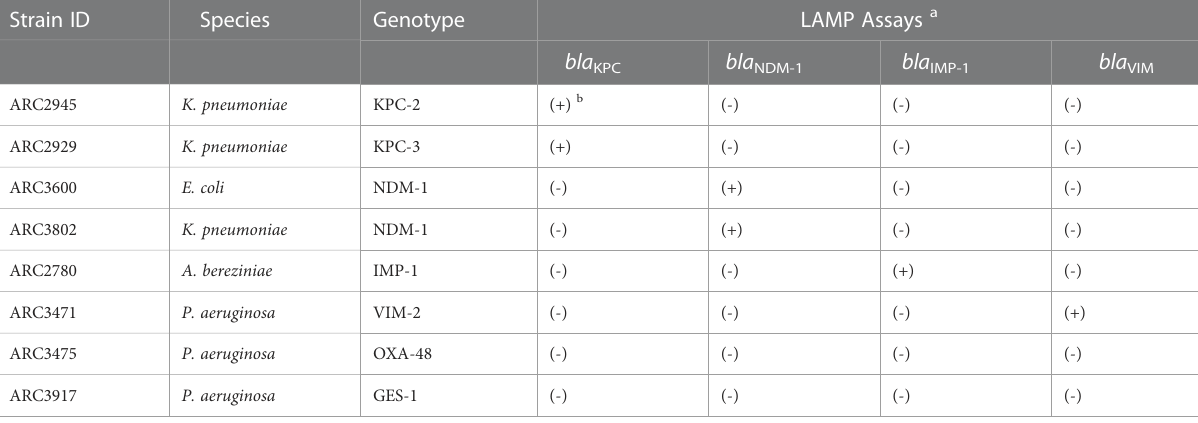
TABLE 1 Reactivities and speci fi cities of LAMP